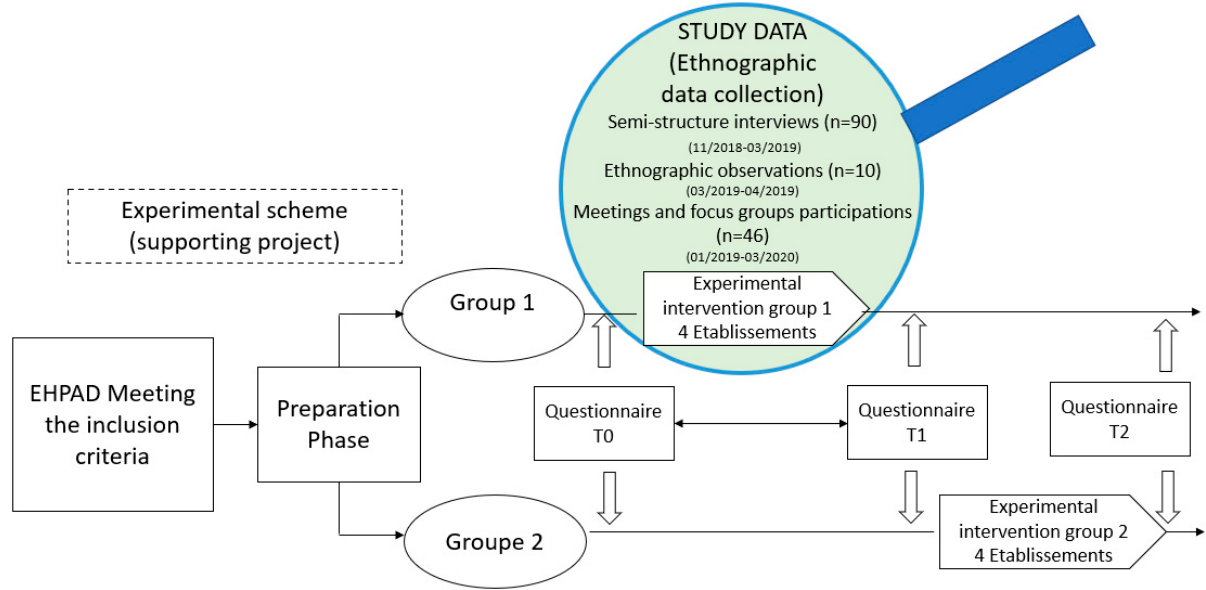
Figure 1. Flow collection of data of the study in the experimental scheme: “Empowerment and Quality of Life at Work in Retirement Homes” program.